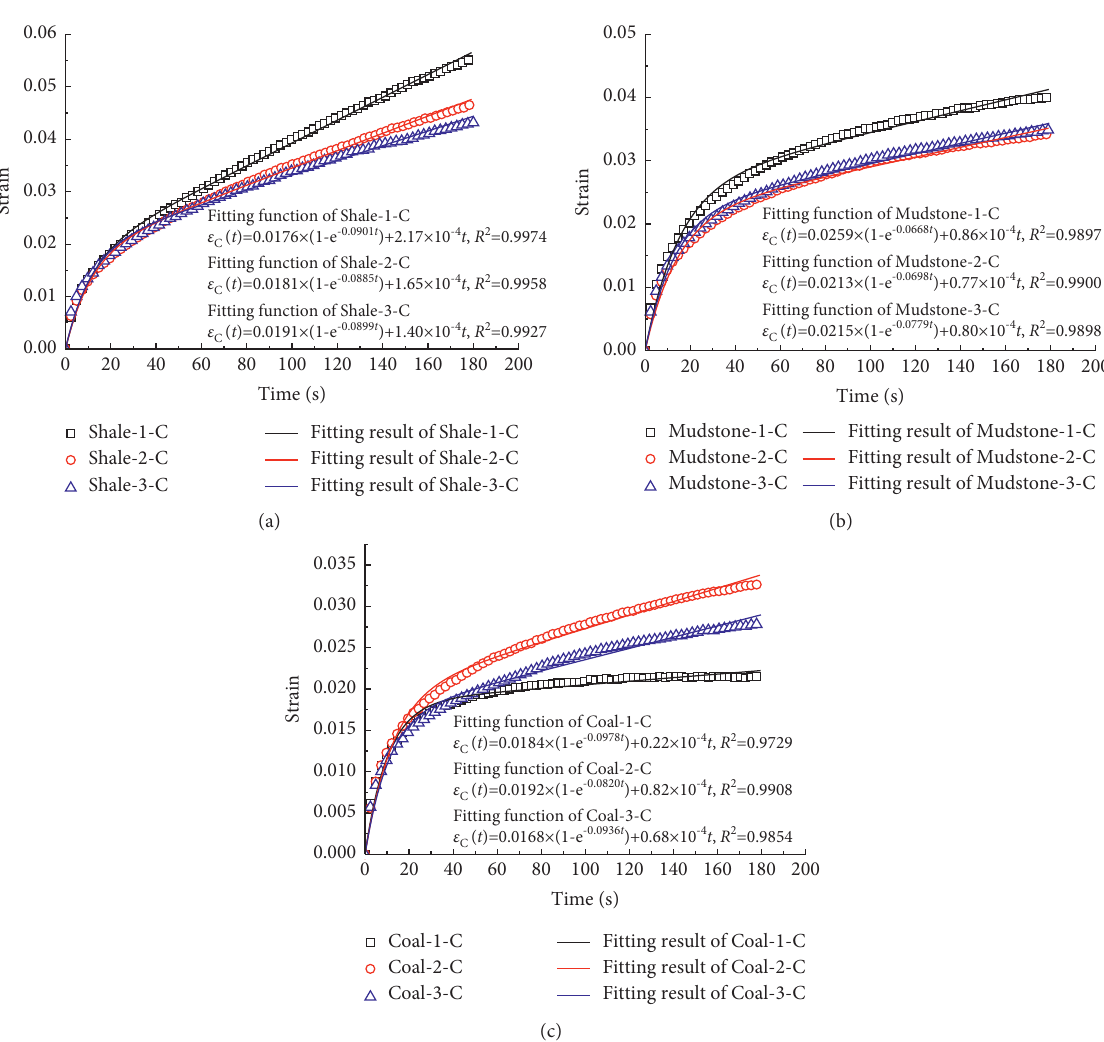
Figure 5: Fitting results of creep curves of (a) shale, (b) mudstone, and (c) coal by using the creep equation of the simplified Burgers model.